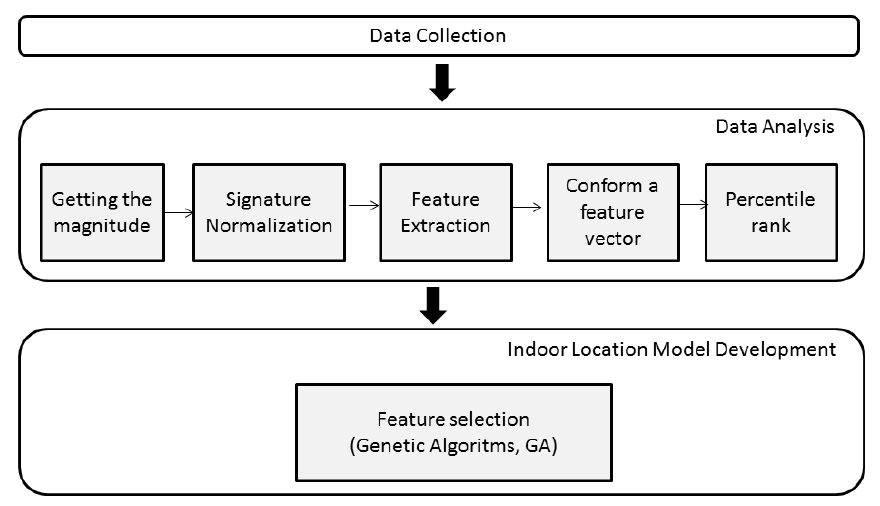
Figure 1. Indoor location